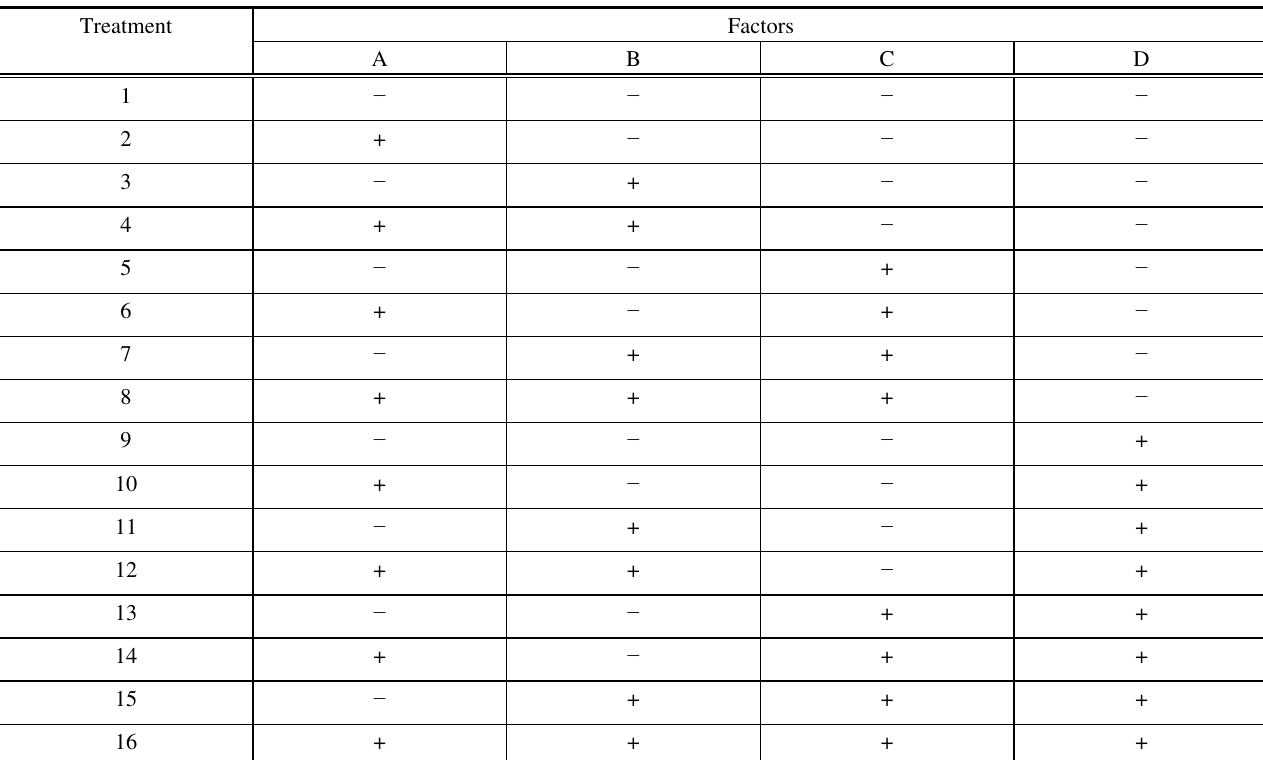
Table 7 Factorial design of two levels and four factors a